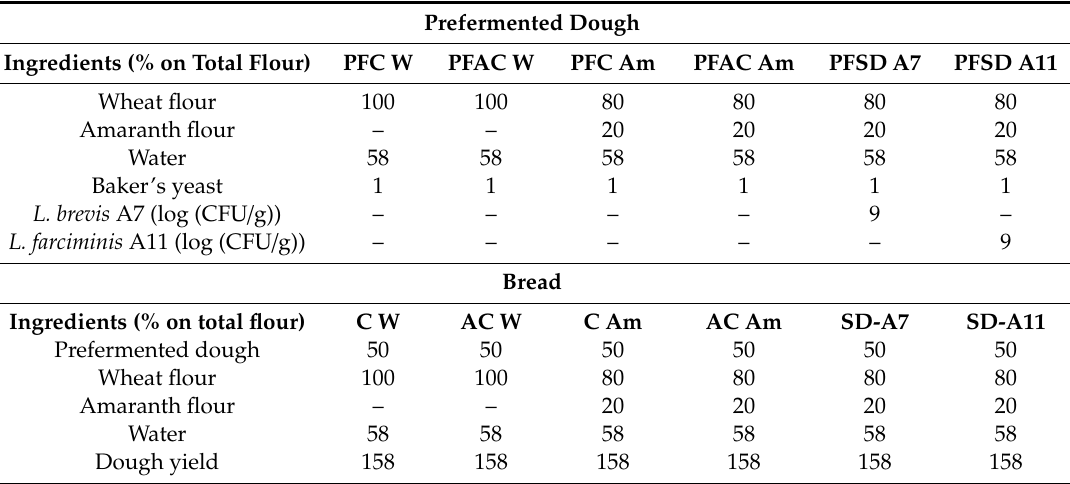
Table 2. Recipes for pre-fermented dough manufacture and bread making and related dough